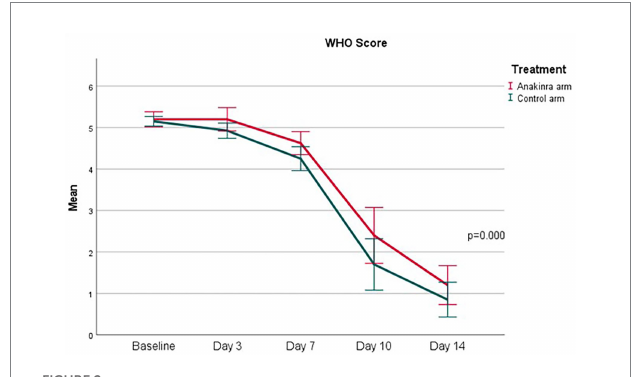
FIGURE 2 Change in the WHO clinical progression Score between day 1 and day